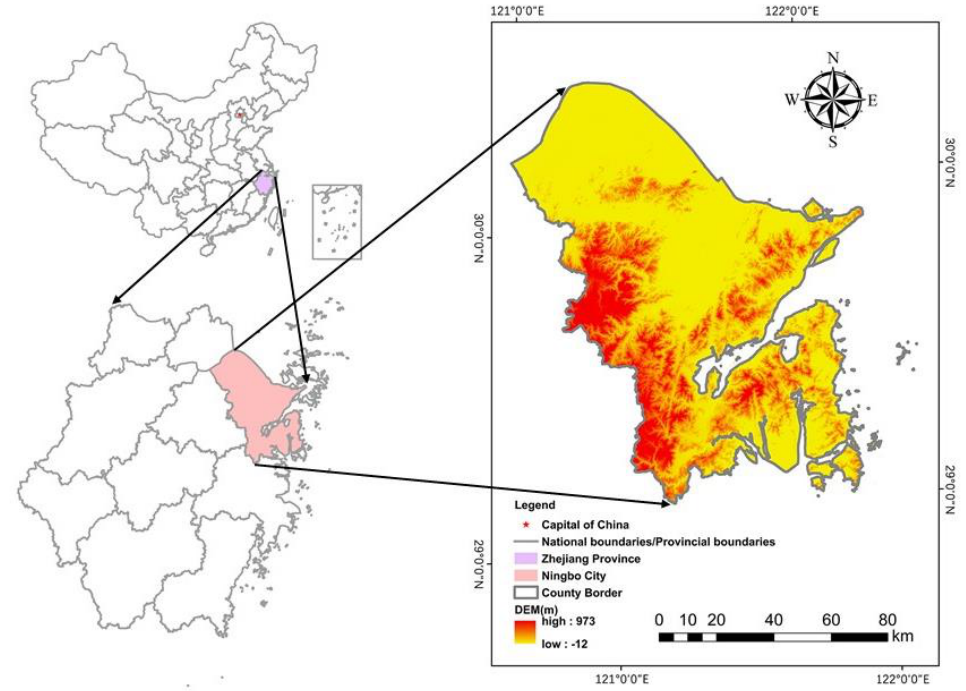
Fig. 1. Geographical location and land use status of